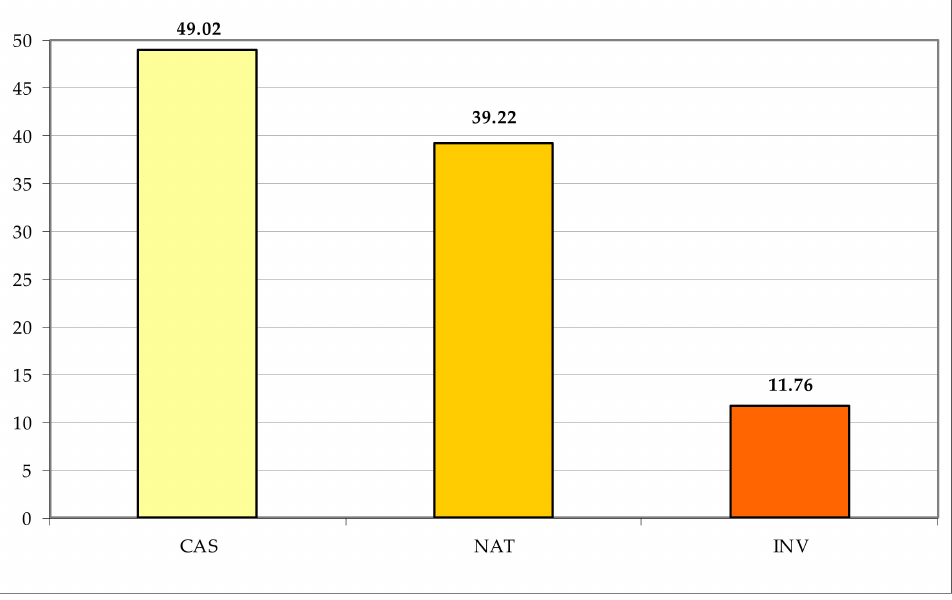
Figure 42. Share of casual (CAS), naturalized (NAT), and invasive (INV) alien plant species and subspecies (percentages in axis y) occurring in Appia Antica Regional